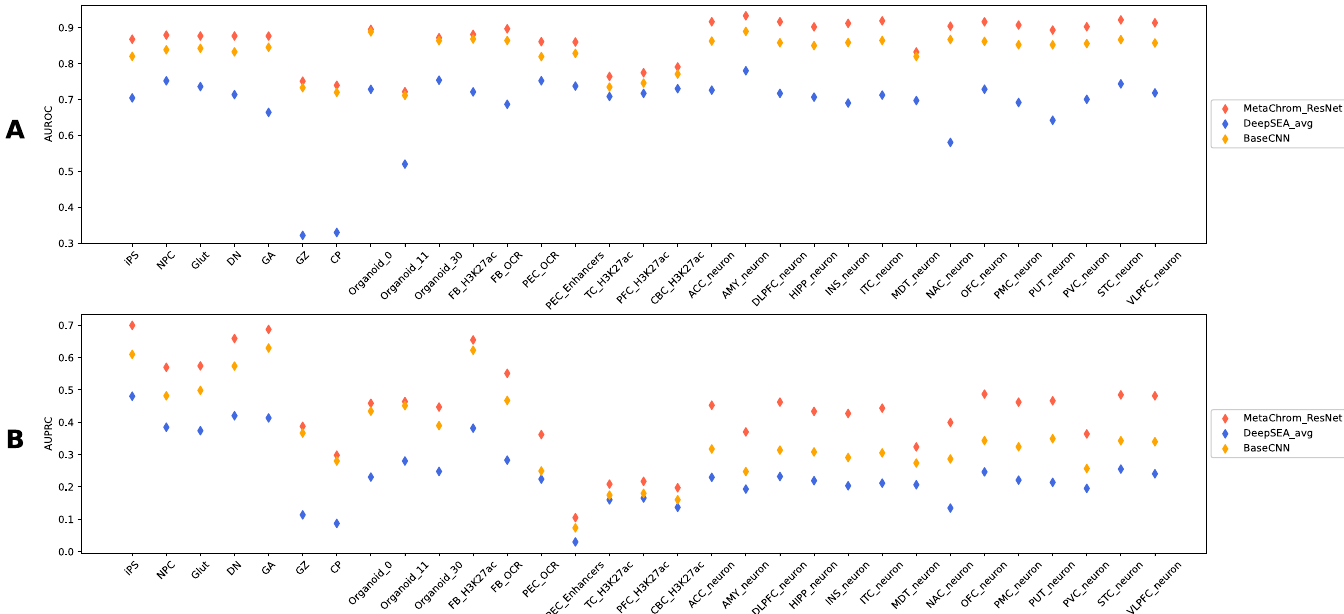
Fig 2. (A) AUROC and (B) AUPRC performance comparison of MetaChrom and DeepSEA method across 31 epigenomic features. NPC, Glut, DN, GA: iPSC-derived neurons. GZ, CP: germinal zone and cortical plate. OCR: open chromatin regions. See Table A in S1 Table for the list of cell/tissue types.